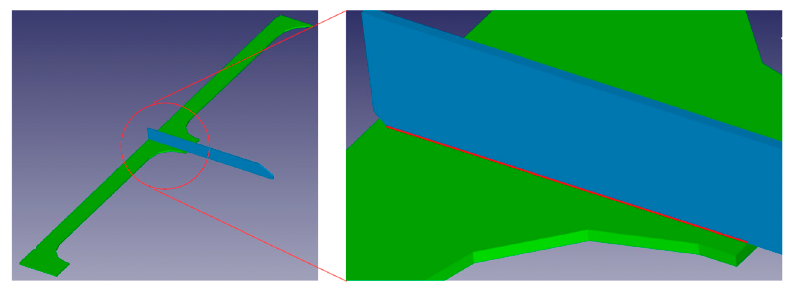
Figure 4. Example of intersection of two members.